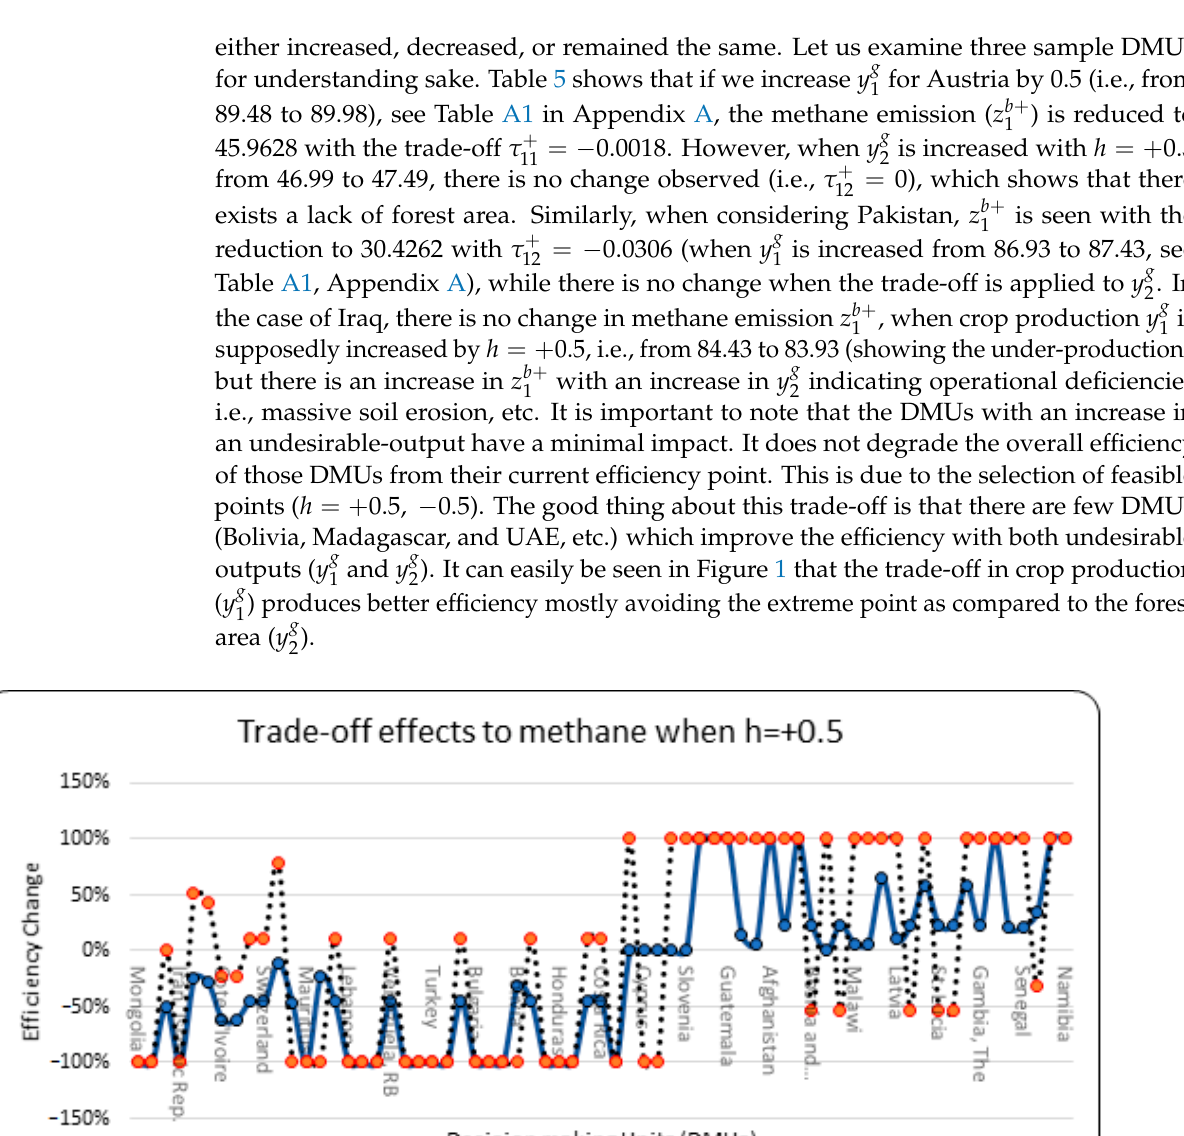
Table 6. Trade-off effects on the methane ( 𝑧 (cid:2869)(cid:3029) ) when ℎ = − 0.5 and 𝑑 = (1, 1).